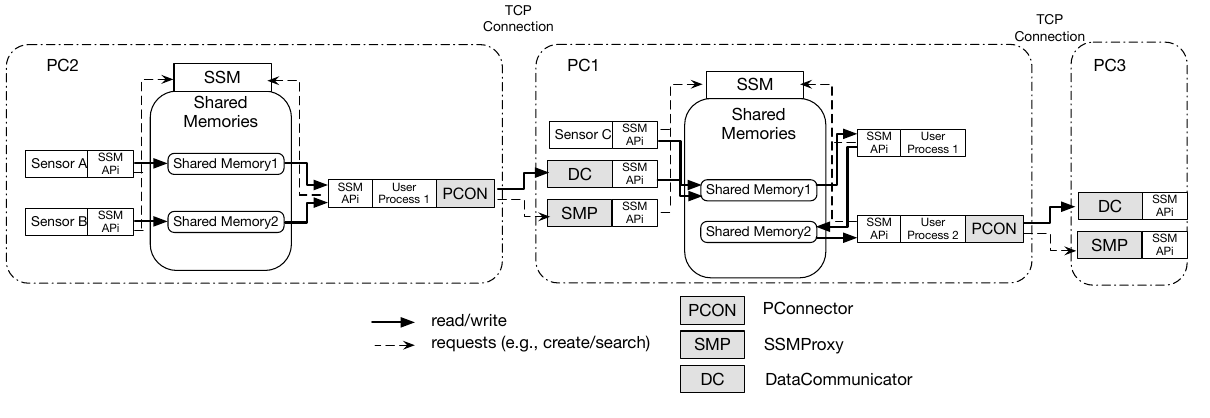
Figure 5. Use case of DSSM.